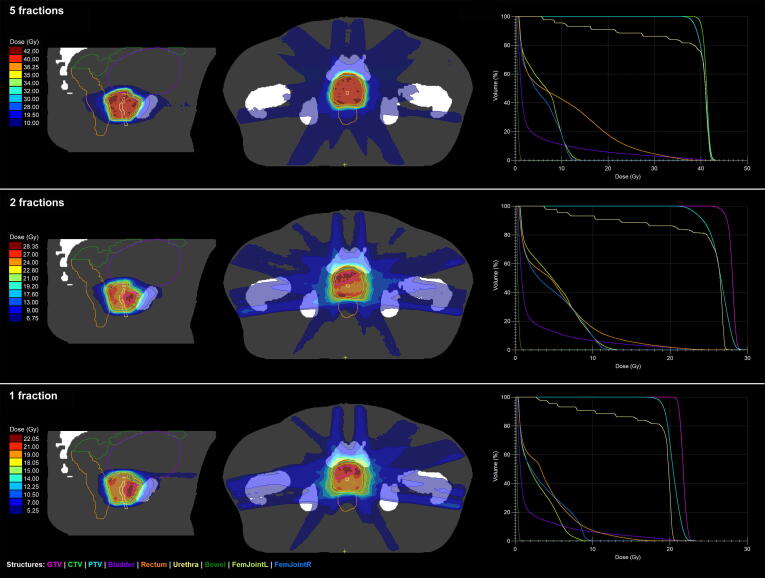
Example Unity MR-Linac stereotactic body radiotherapy dose distributions for plans created for one patient using the three fractionation schemes. Synthetic CT data is displayed, illustrating the bulk density assignment used for dose calculation.